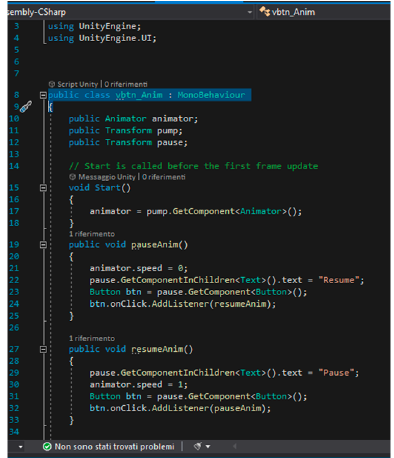
Figure 17. Script for the pause/resume UI button.